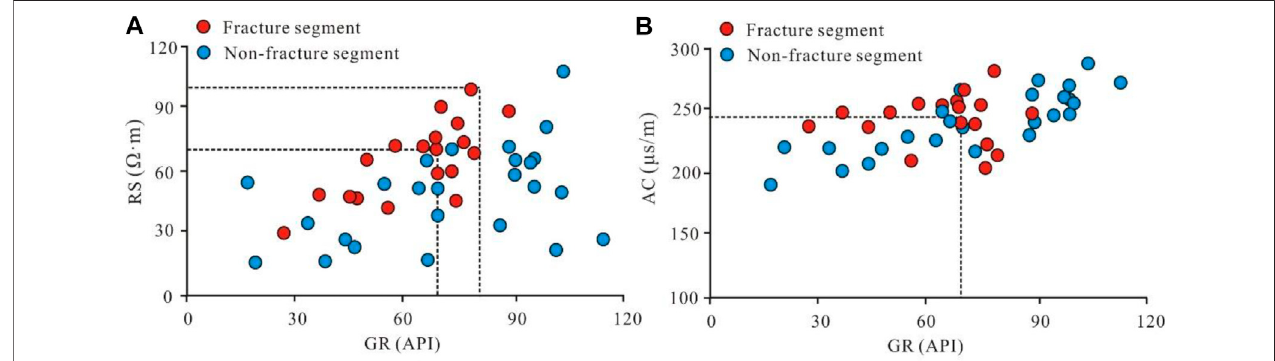
FIGURE 8 | Sensitivity analysis of fractures to conventional logging parameters of target sandstone. (A) Relationship between RS and GR of fractured and non- fractured sandstones; (B) Relationship between AC and GR of fractured and non-fractured sandstones. GR-natural gamma; RS-shallow lateral resistivity; AC- longitudinal wave time difference.